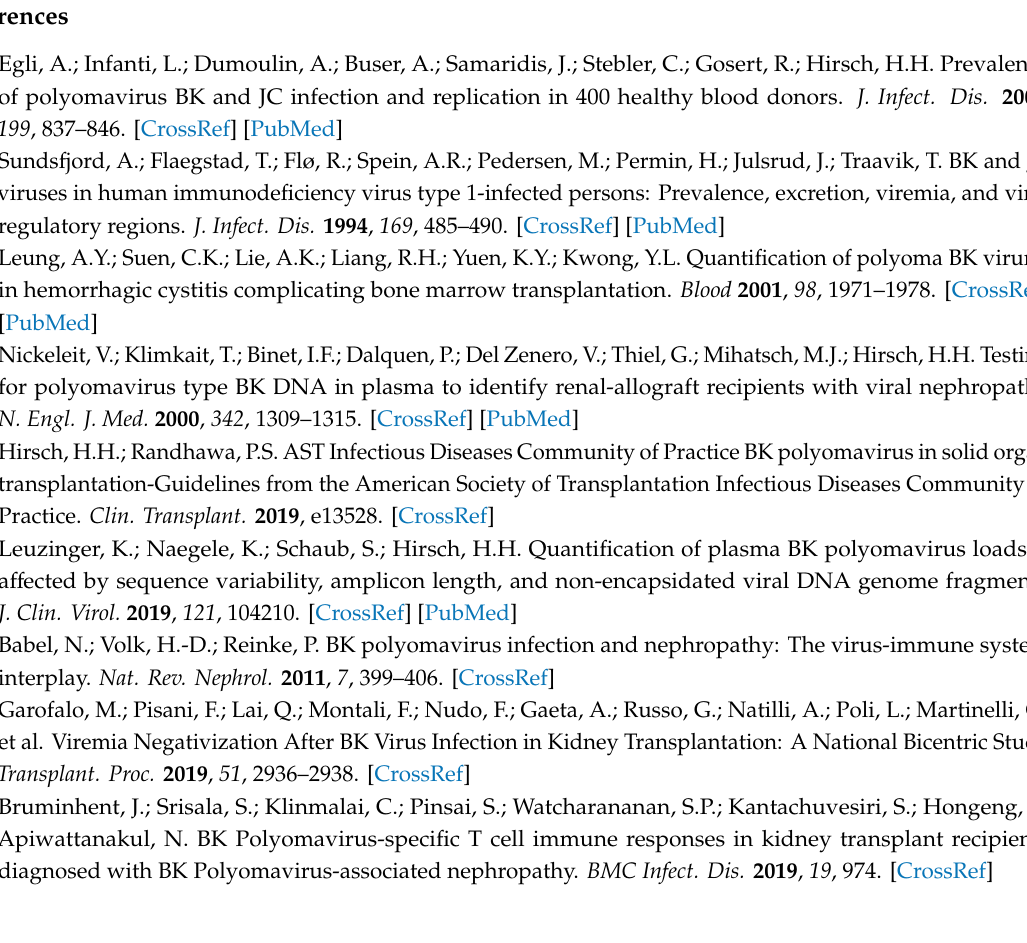
Figure S1: Calculation of ratio of infectious particles to pEGFP copies for pseudotype virus with di ff erent VP1 variants in HEK 293TT cells. Figure S2. TAg expression in Vero cells transfected with recircularized pBKV 35-1 plasmid carrying either Wild-type or mutant VP1. Figure S3: Increased pseudotype virus dose significantly reduces measured neutralizing titre. Figure S4. Neutralization of PSV carrying VP1 variants in RS cells. Figure S5: Cumulative e ff ect of VP1 mutations on neutralization escape. Table S1: VP1 mutants produced and